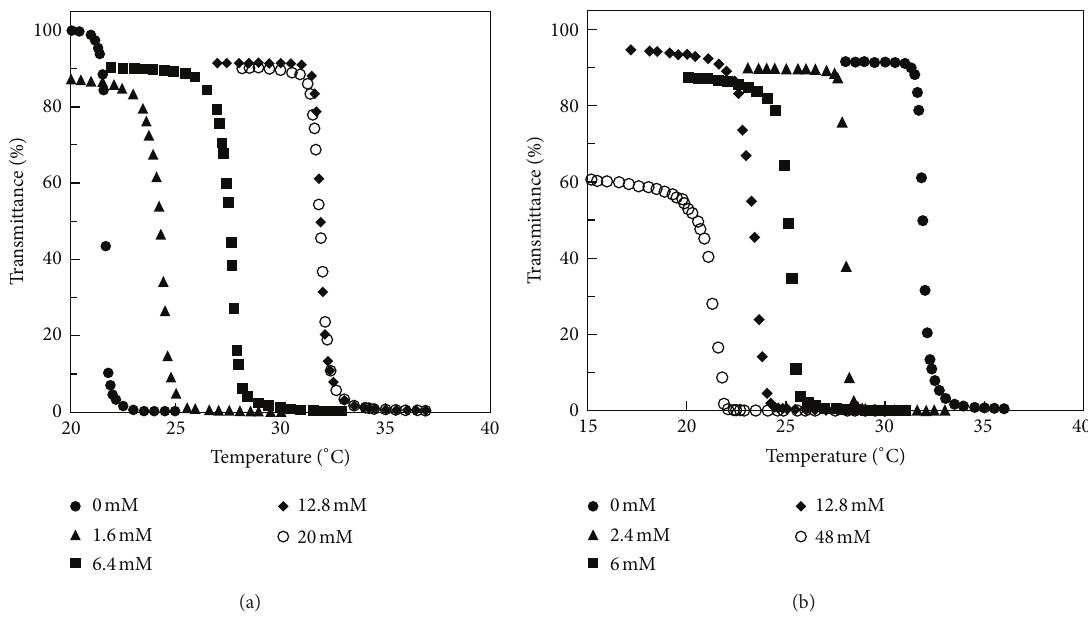
Figure 3: (a) Transmittance change of 10mg/mL solutions of the poly(TEMPOMA- ran -NIPAAm) ( 1 󸀠 ) in 0.1M Na 2 SO 4 aq in the presence of various amounts of L-ascorbic acid 0–20.0 mM and (b) transmittance change of the resulting solutions of the corresponding reduced copolymer in the presence of various amounts of K 3 [Fe(CN) 6 ].